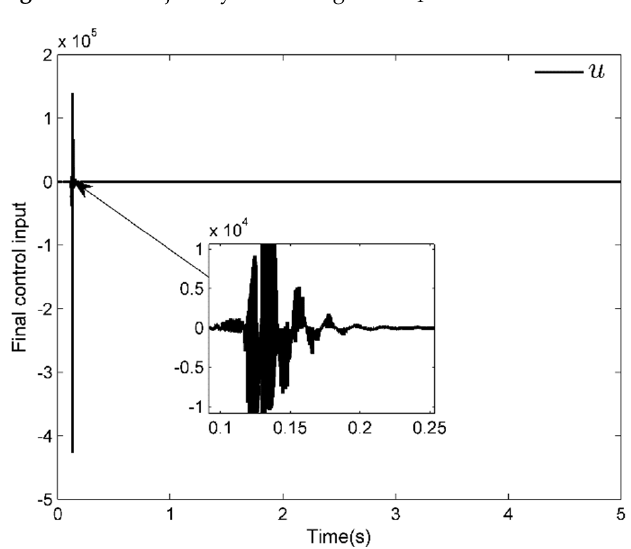
Figure 3. The curve of control input u ( t ) .